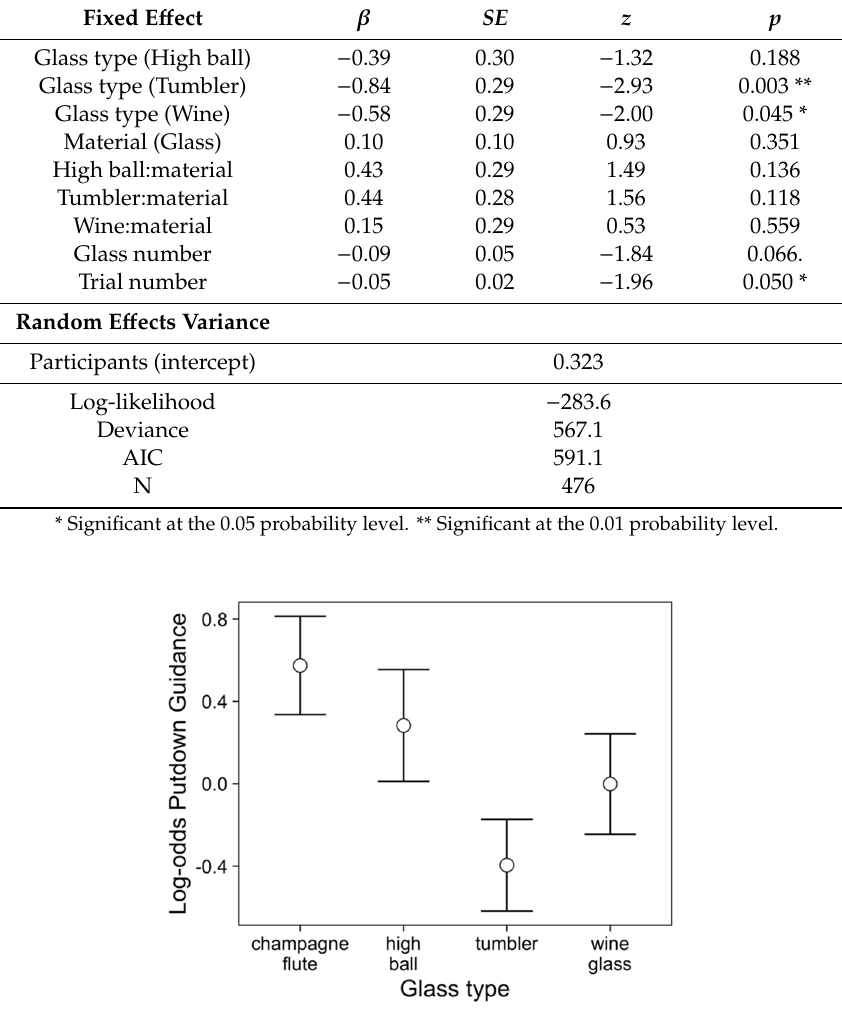
Figure 3. Log-odd plots of guided putdowns (for putdown 1) across participants split by glass type, with 95% confidence intervals. Higher log-odds represent a higher probability of the vessel being guided on put-down. This plot was created by removing the variability due to other factors (from the GLMM). Individual plots for each participant are shown in Appendix A Figure A1.